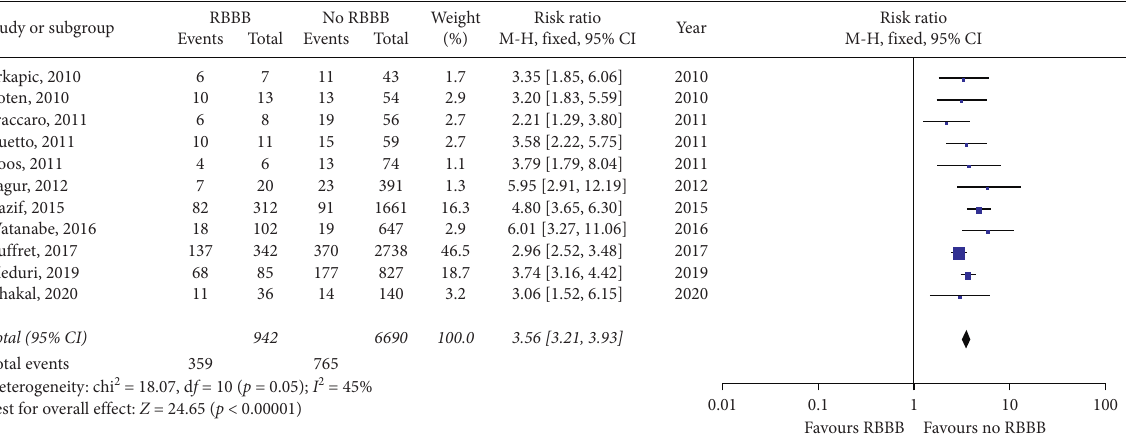
Figure 2: Forest plot of 30-day PPI rates in patients with and without preexisting RBBB after